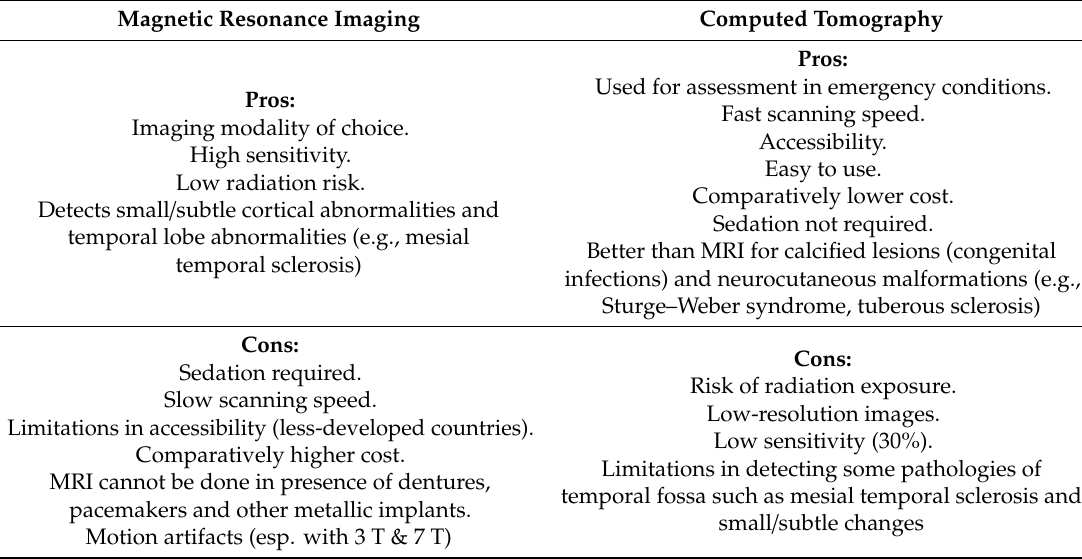
Table 2. Advantages and disadvantages of MRI vs. CT.